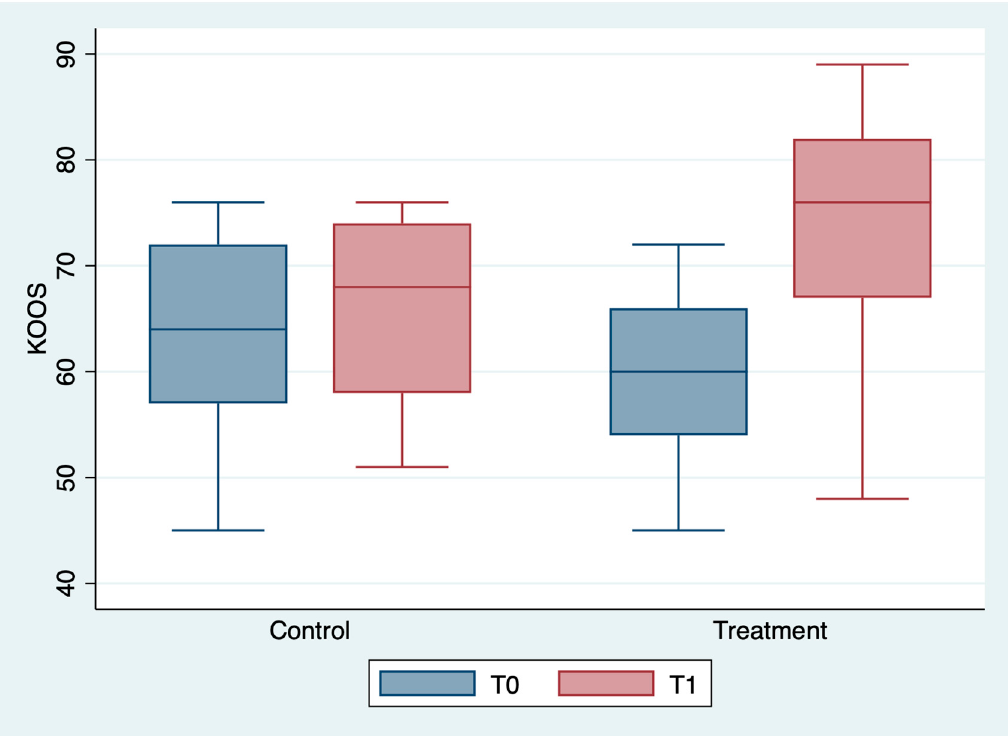
Figure 5. Box plot of KOOS values by detection time and group.